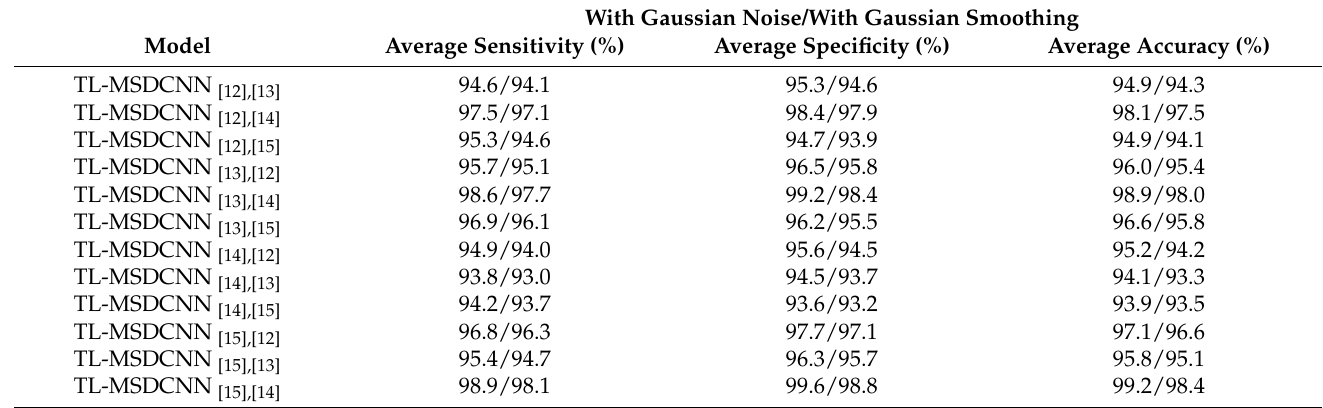
Table 6. Performance of the 12 target models using TL-MSDCNN when Gaussian noise and Gaussian smoothing are considered. With Gaussian Noise/With Gaussian Smoothing